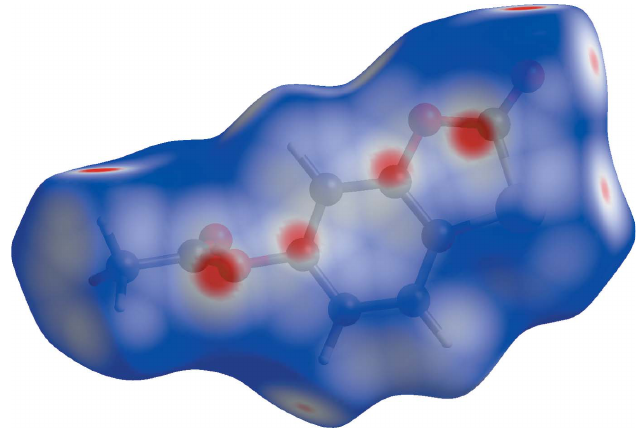
Figure 8 Hirshfeld surface plot mapped over d norm for (II) showing red spots associated with short C (cid:3)(cid:3)(cid:3) C and C (cid:3)(cid:3)(cid:3) O contacts: the slightly smaller spots refer to the former.